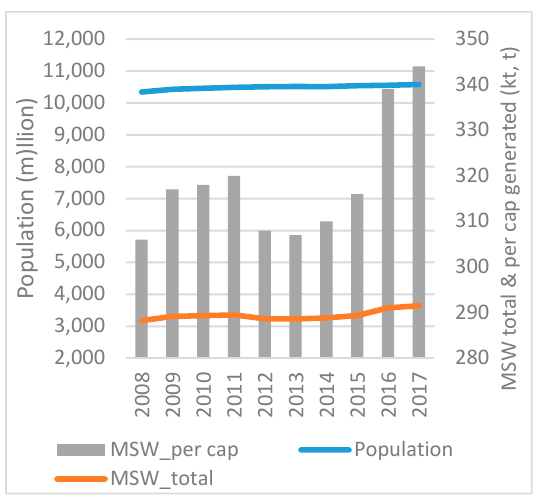
Figure 4. Waste treatment methods and PPP in Bulgaria 2008–2017 (EUROSTAT 2019b, 2019c).